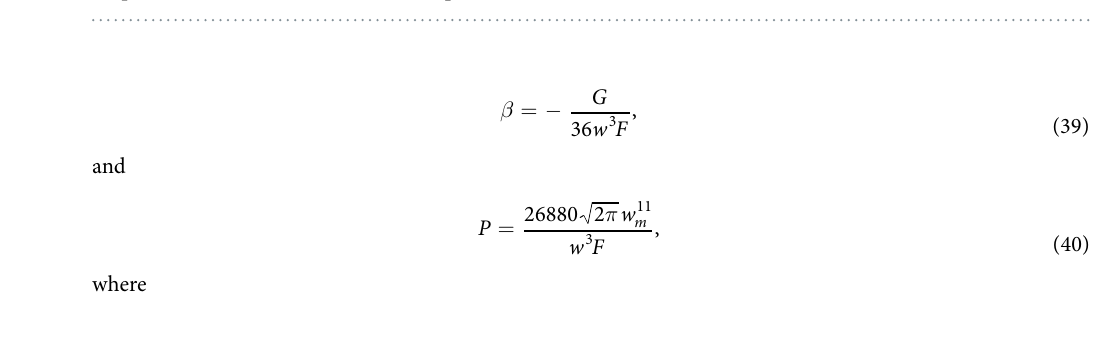
Figure 10. Propagation of tripole-mode solitons in the presence of 1% white input noise by expanding the response function to the tenth order. ( a , b ) Correspond to the cases of Fig. 3(a,d), respectively, and the input shapes in ( a , b ) are obtained based on Eqs